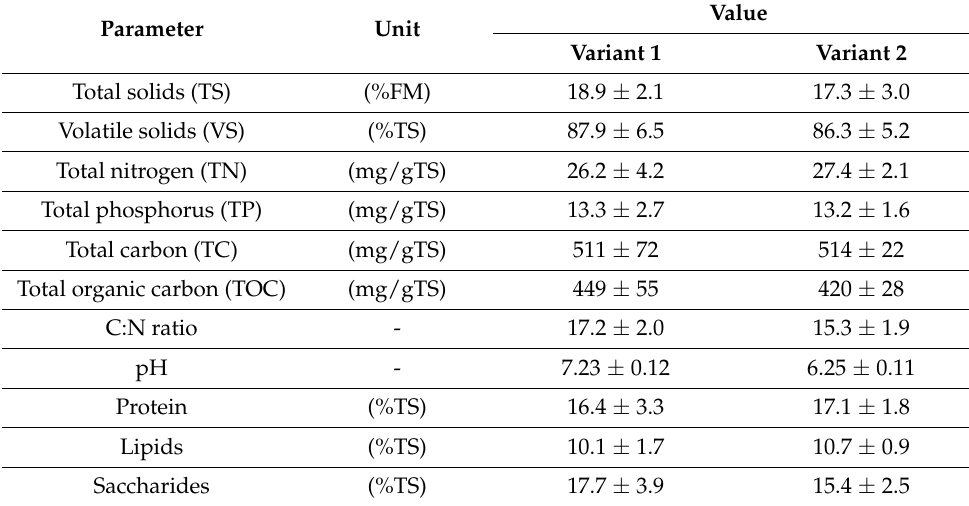
Table 1. Characteristics of the biomass of hydrophytes harvested by mowing the bank zones of water reservoirs in stage 1 of the